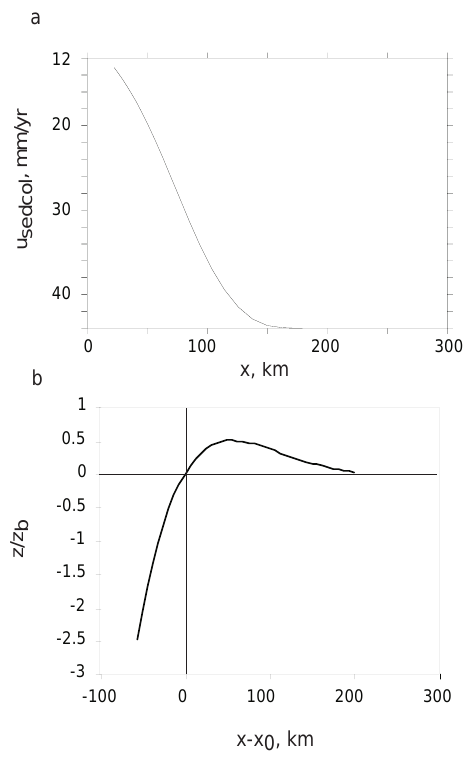
Fig. 1. (a) The sediment column velocity (negative meaning from right to left) for the Base scenario. (b) The solution to the plate flexure/isostasy balance near the subducting